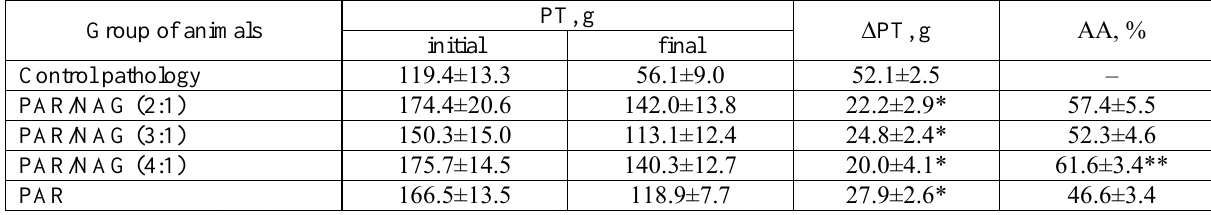
Results of the assessment of paracetamol and N-acetyl-D-glucosamine ratio in the composition Group of animals